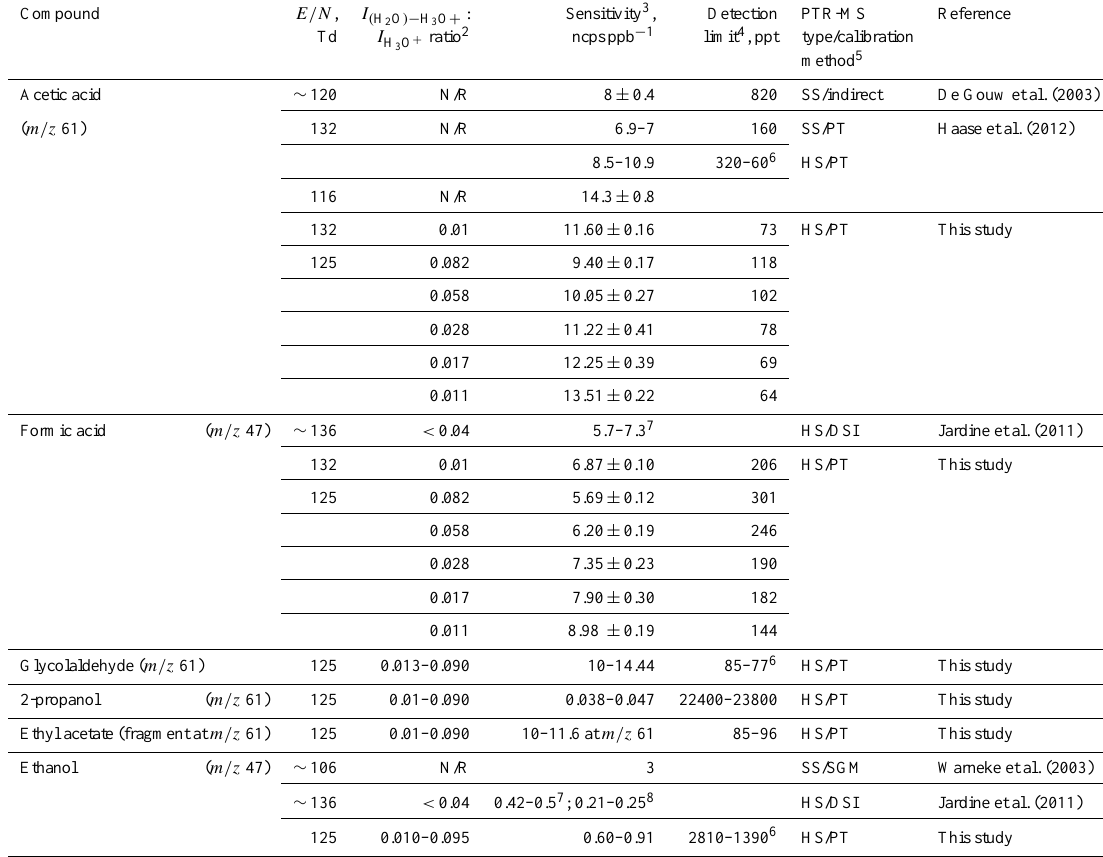
Table 1. PTR-MS sensitivities toward acetic acid (AA), formic acid (FA), and related species at m/z 47 and m/z 61 as reported in the literature and in this study 1